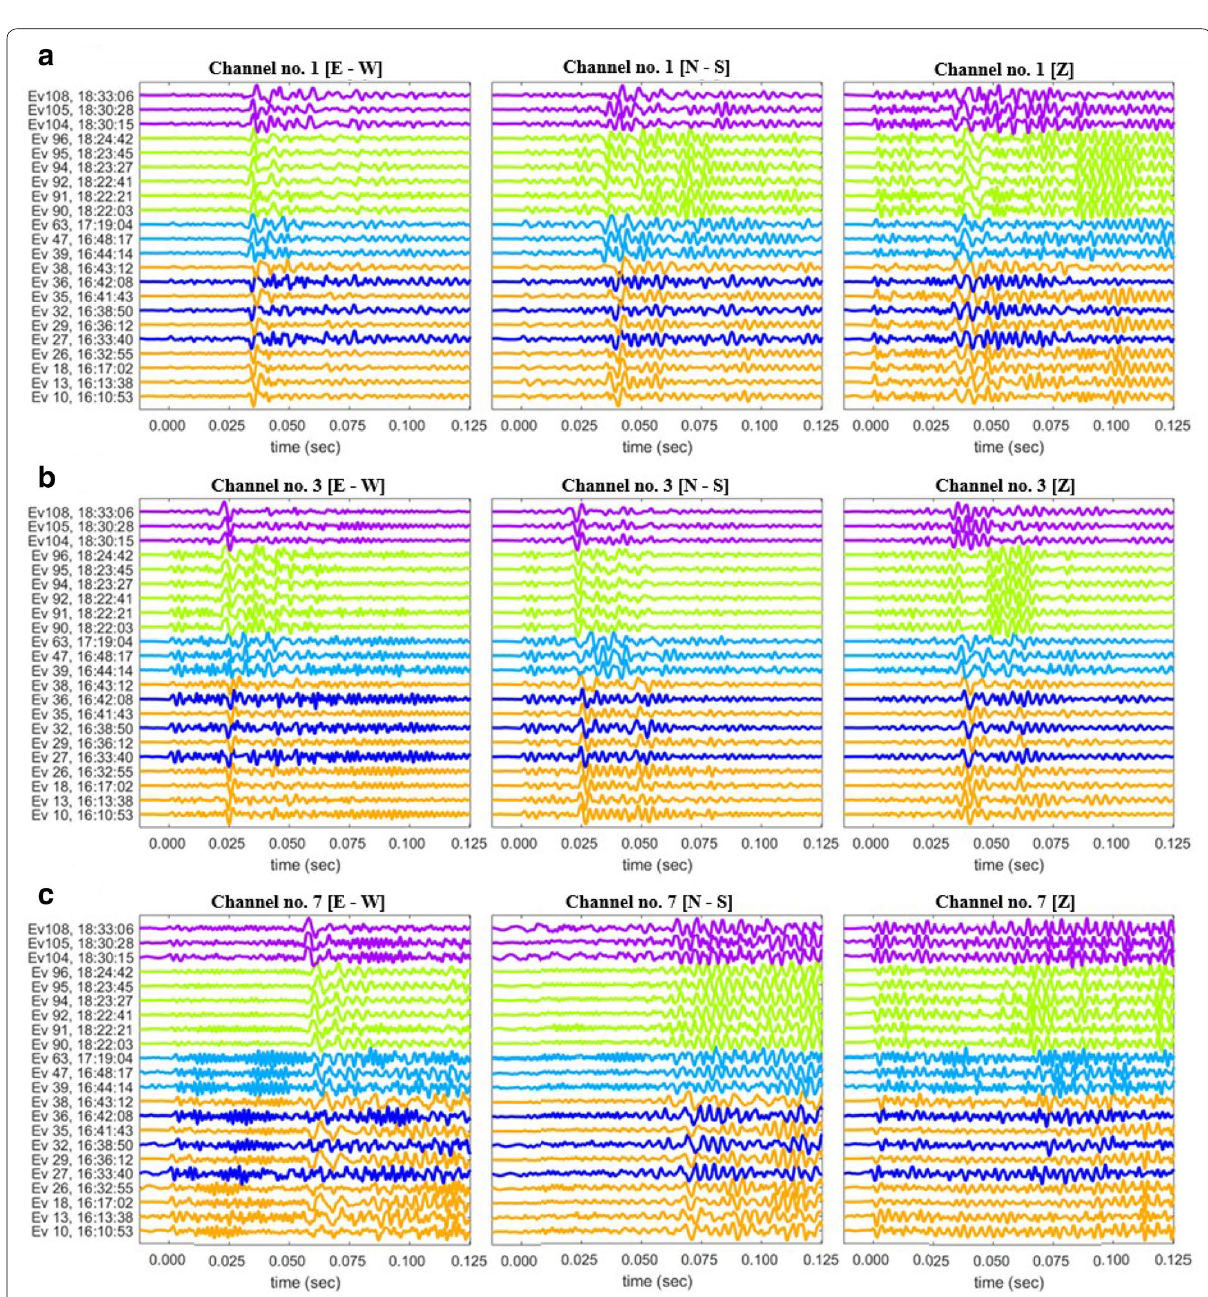
Fig. 6 Waveforms of microseismic events in area A, from three components (3 of 8 channels are shown) colored based on multiplet groups: A1, A2, A3, A4,